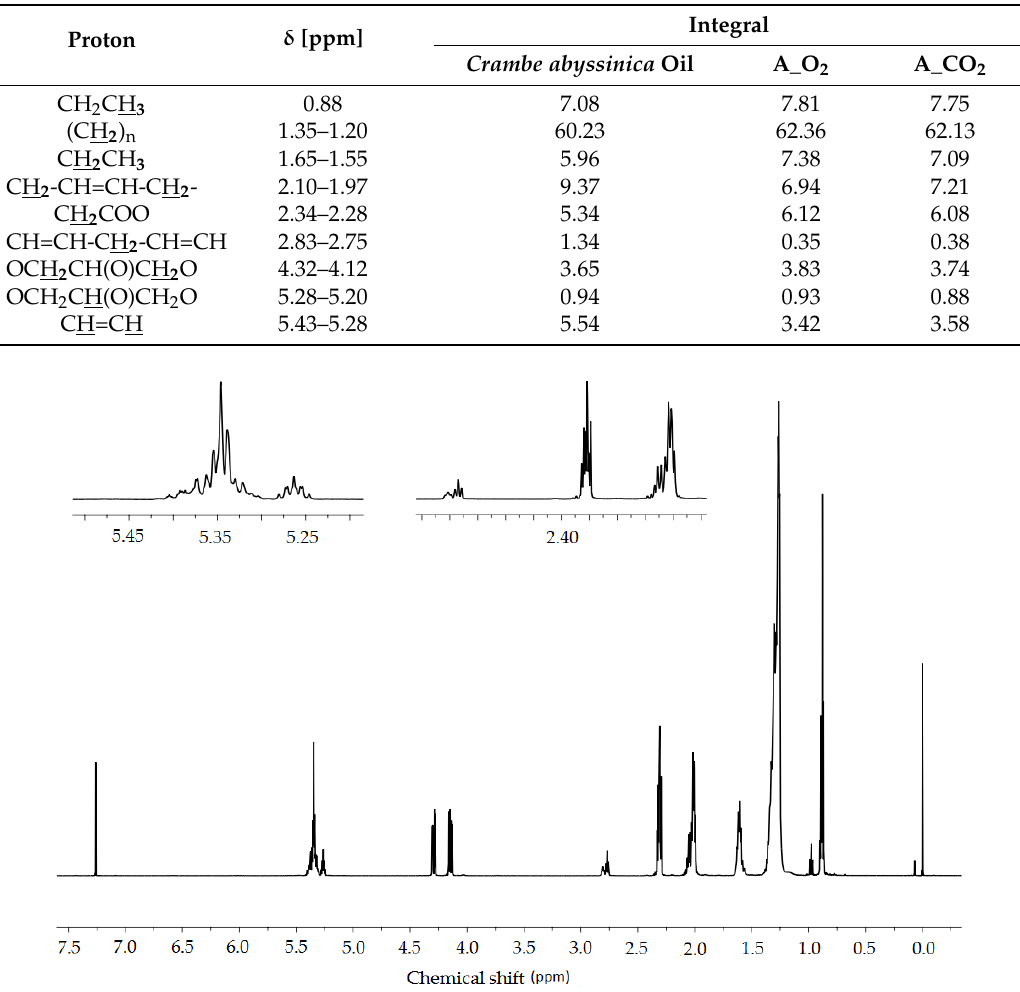
Figure 10. 1 H-NMR spectrum (600 MHz, CDCl 3 ) of crude Crambe abyssinica oil: δ 0.88 (t, 9H, J = 0.88 Hz, CH 2 CH 3 ), 1.35–1.20 (m, 70H, (CH 2 ) n ), 1.65–1.55 (m, 6H, CH 2 CH 3 ), 2.10–1.97 (m, 12H, CH 2 -CH=CH-CH 2 -), 2.34–2.28 (m, 6H, CH 2 COO), 2.83–2.75 (m, 2H, CH=CH-CH 2 -CH=CH), 4.32–4.12